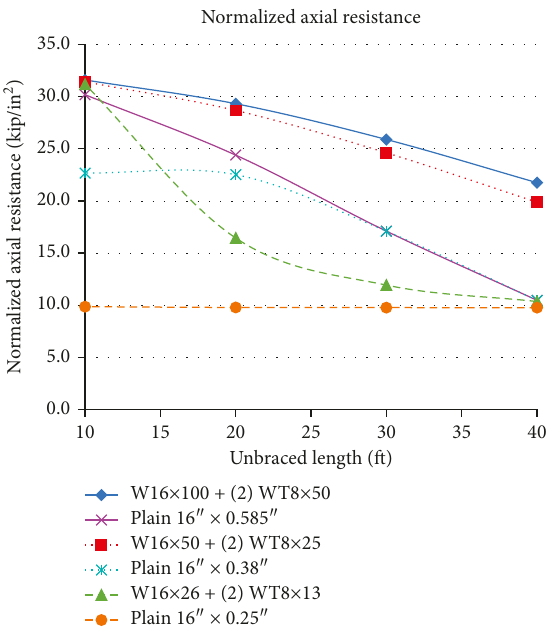
Figure 6: Normalized axial resistance for comparative plain and flanged cruciform members (1 ft 6.895 MPa).